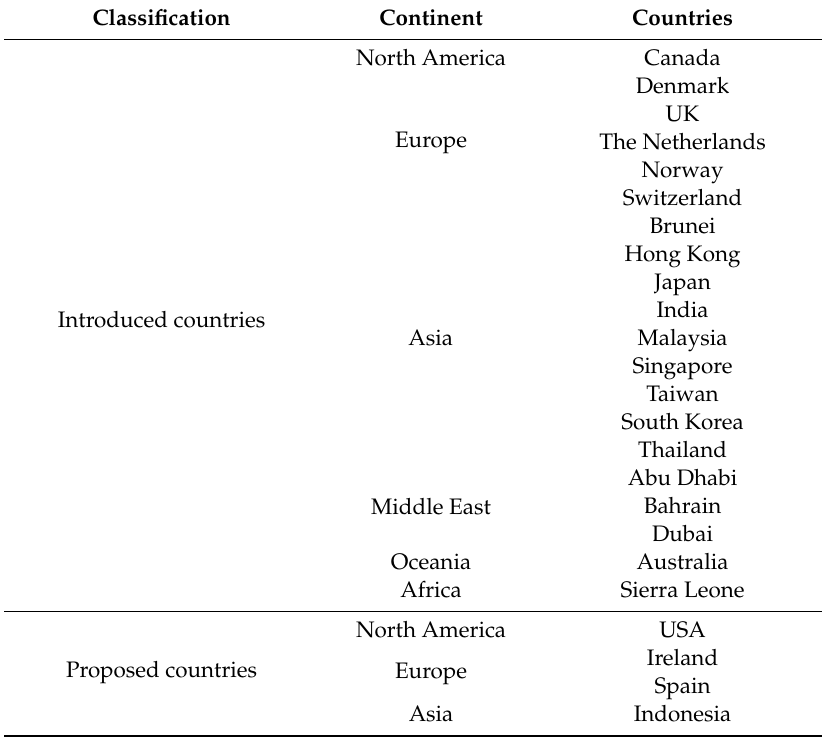
Table 1. The countries introduced and proposed the regulatory sandbox (April 2019) 1